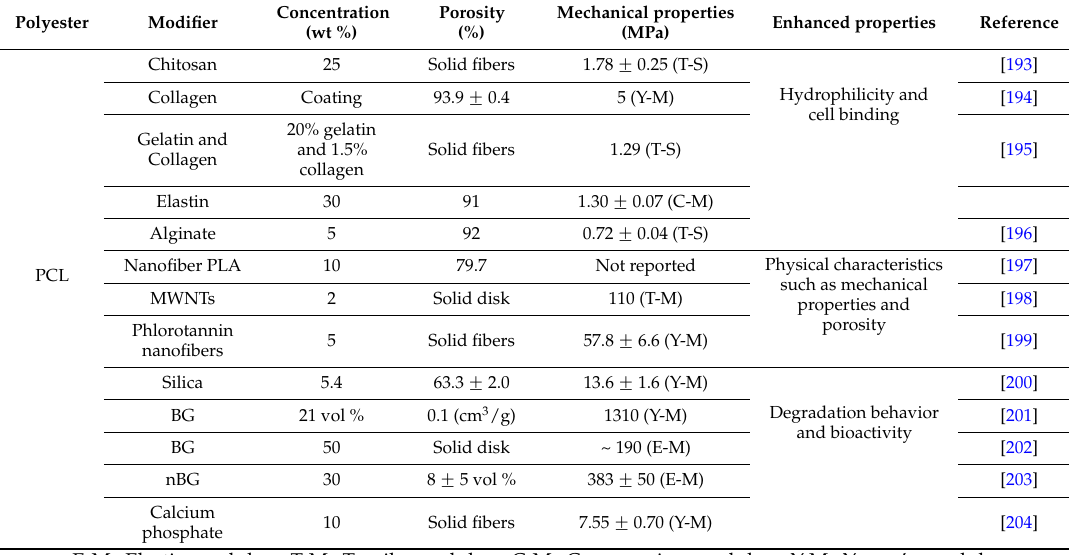
Table 7. Modification methods of poly ( ε -caprolactone) (PCL)-based composites for biomedical and tissue engineering